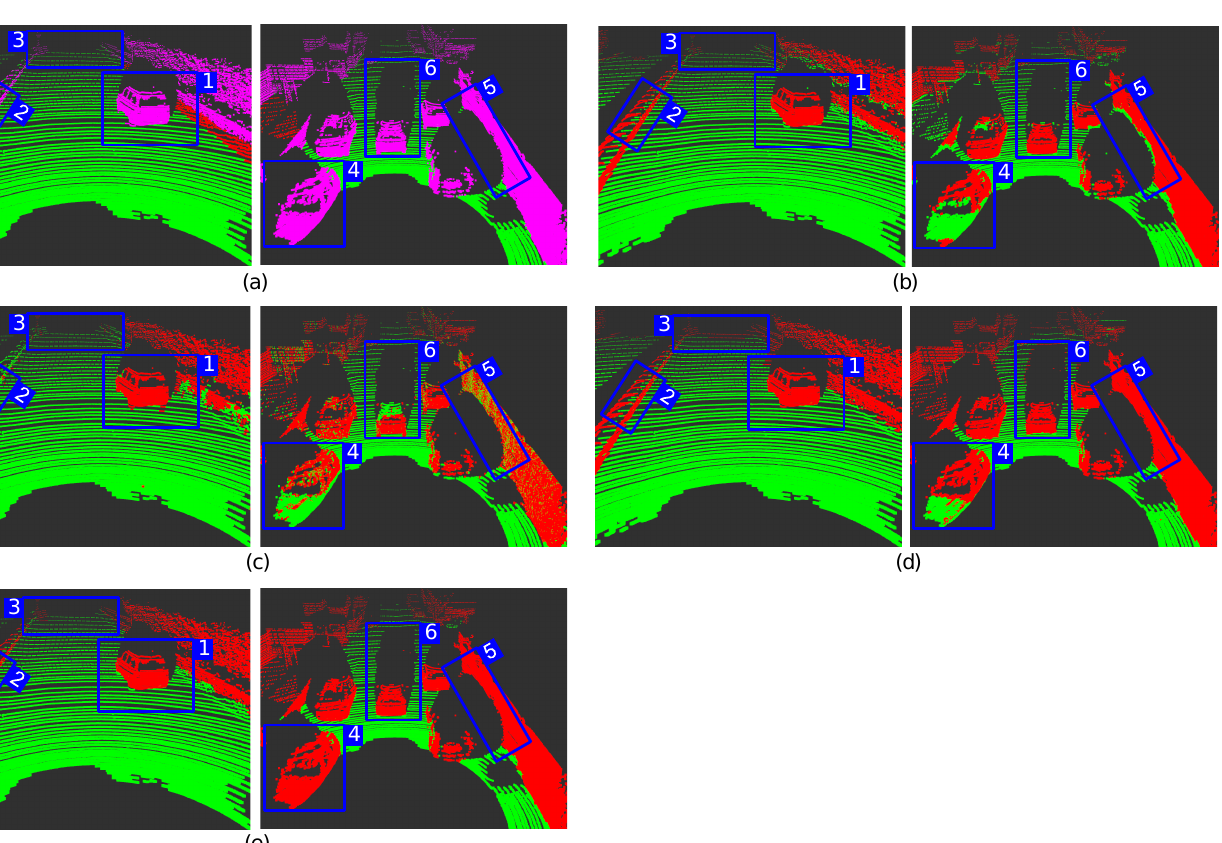
Figure 10. The ground segmentation effect of different methods on Semantickitti dataset. ( a ) Benchmark; ( b ) Chu [15]; ( c ) Bogoslavskyi [23]; ( d ) Huang [34]; ( e ) Ours. (It is recommended to zoom in to see the